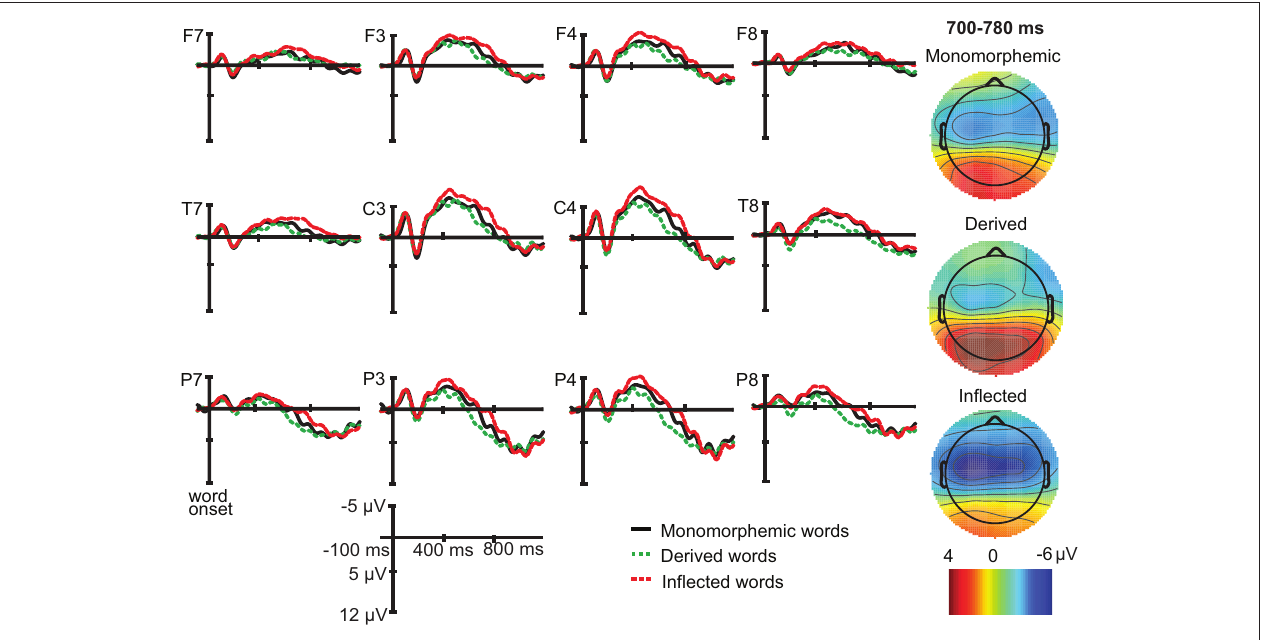
of the stimuli. Negative polarity is plotted upwards. X -axis represents time (milliseconds), Y -axis depicts voltage (microvolts, μV). (Right) topographic maps of the distribution of the negativity in the 700–780 ms time windows after stimulus onset for monomorphemic, derived, and inflected